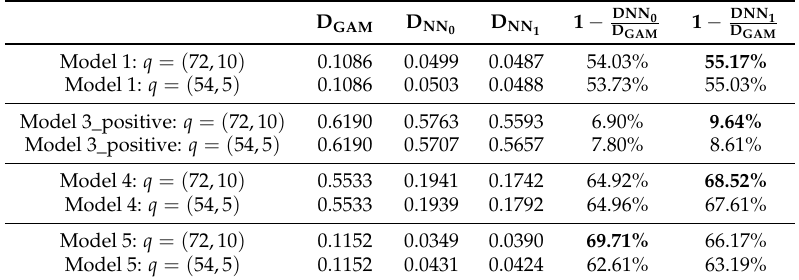
Table 3. Minimal cross-entropy and deviance loss functions on validation sets observed during the training of the neural networks in k =